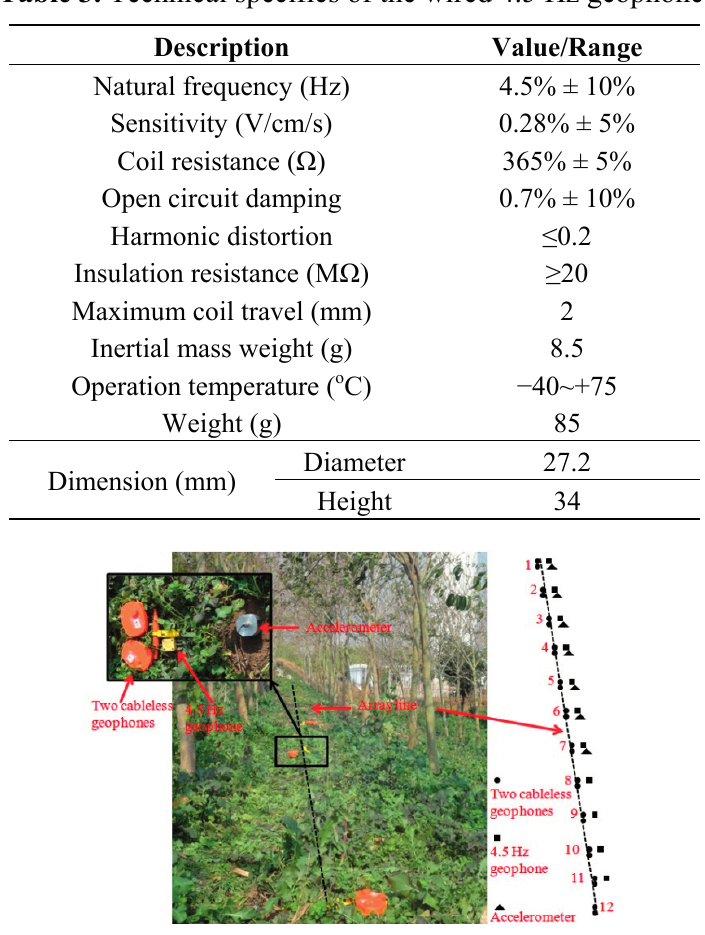
Table 3. Technical specifics of the wired 4.5 Hz geophone.